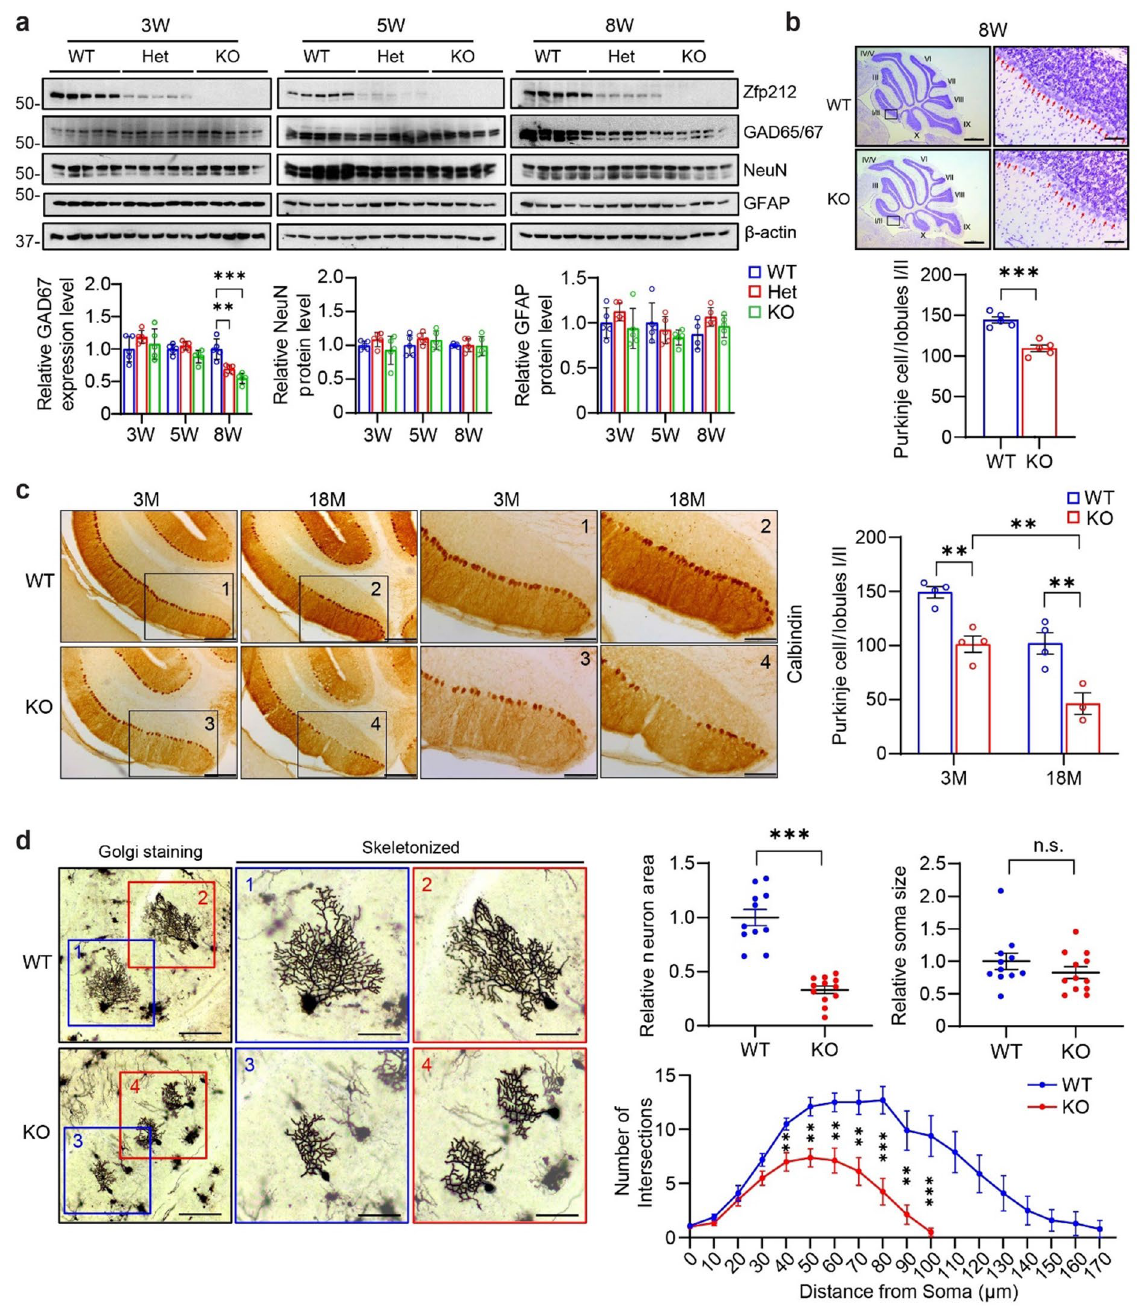
Figure 2. Adult Zfp212-KO mice show cerebellar Purkinje cell death. ( a ) Immunoblot analysis of Zfp212, GAD65/67, NeuN, and GFAP in Zfp212-WT, -Het, and -KO cerebella at three different time points (3, 5, and 8 weeks of age). Lower panels are the quantification of the immunoblot (3 weeks: n = 5 per group, 5 weeks: n = 5 per group, 8 weeks: n = 5 per group). ( b ) Representative image of Nissl staining in the cerebellum of Zfp212-WT and -KO mice at 8 weeks of age. The number of Purkinje cells in lobules I/II was counted (at the bottom of panel b , n = 5). Scale bars = 800 μm at the original image and 80 μm at the enlarged image, respectively. ( c ) Representative image of DAB staining for calbindin in the cerebellum of Zfp212-WT and -KO mice. Quantification of Purkinje cells/lobules I/II is shown on the right ( n = 3). Scale bars = 200 μm at the original image and 100 μm at the enlarged image, respectively. ( d ) Golgi staining of Purkinje cells and their skeletonized images in Zfp212-WT and -KO cerebella at 3 months of age (WT: n = 11, KO: n = 11). Scale bars = 100 μm at the original image and 50 μm at the enlarged image, respectively. n.s., not